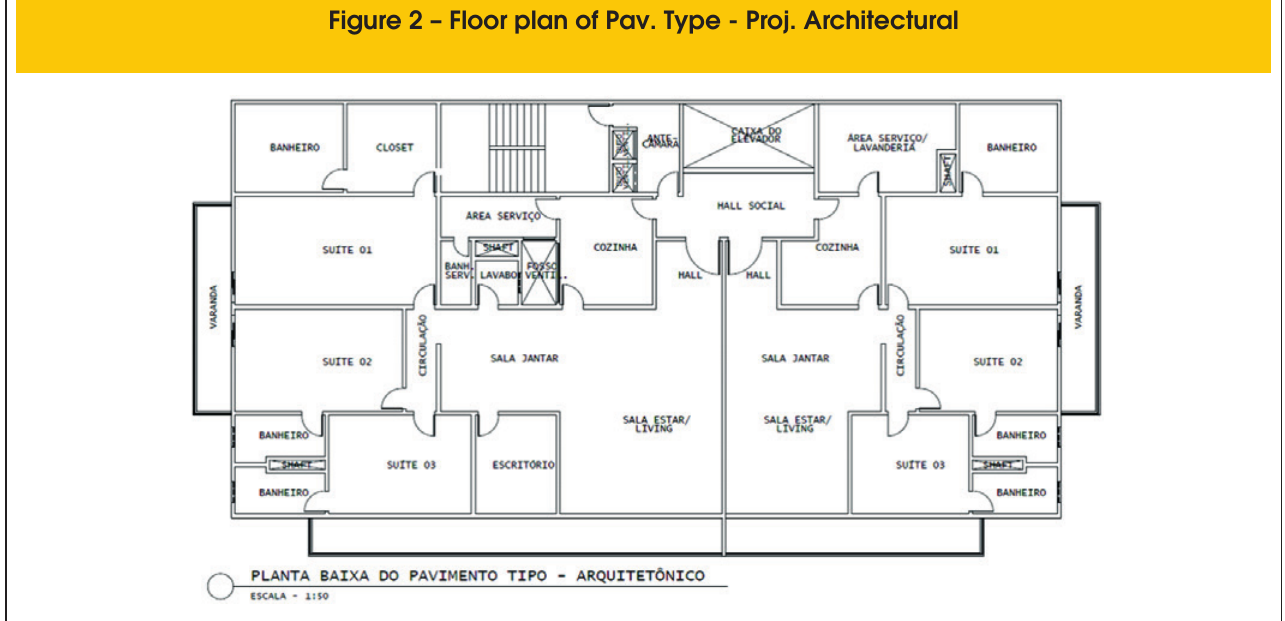
Figure 2 – Floor plan of Pav. Type - Proj.